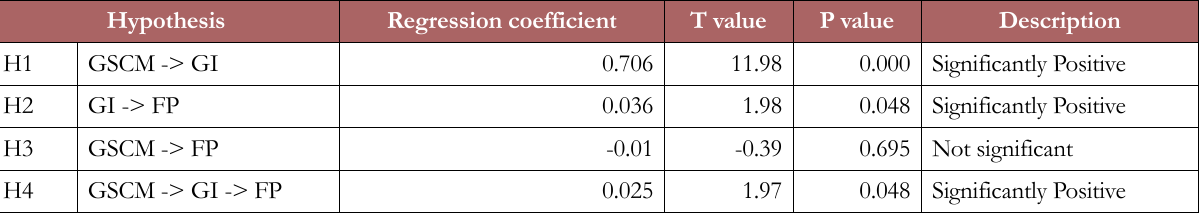
Table 5. Hypothesis Test